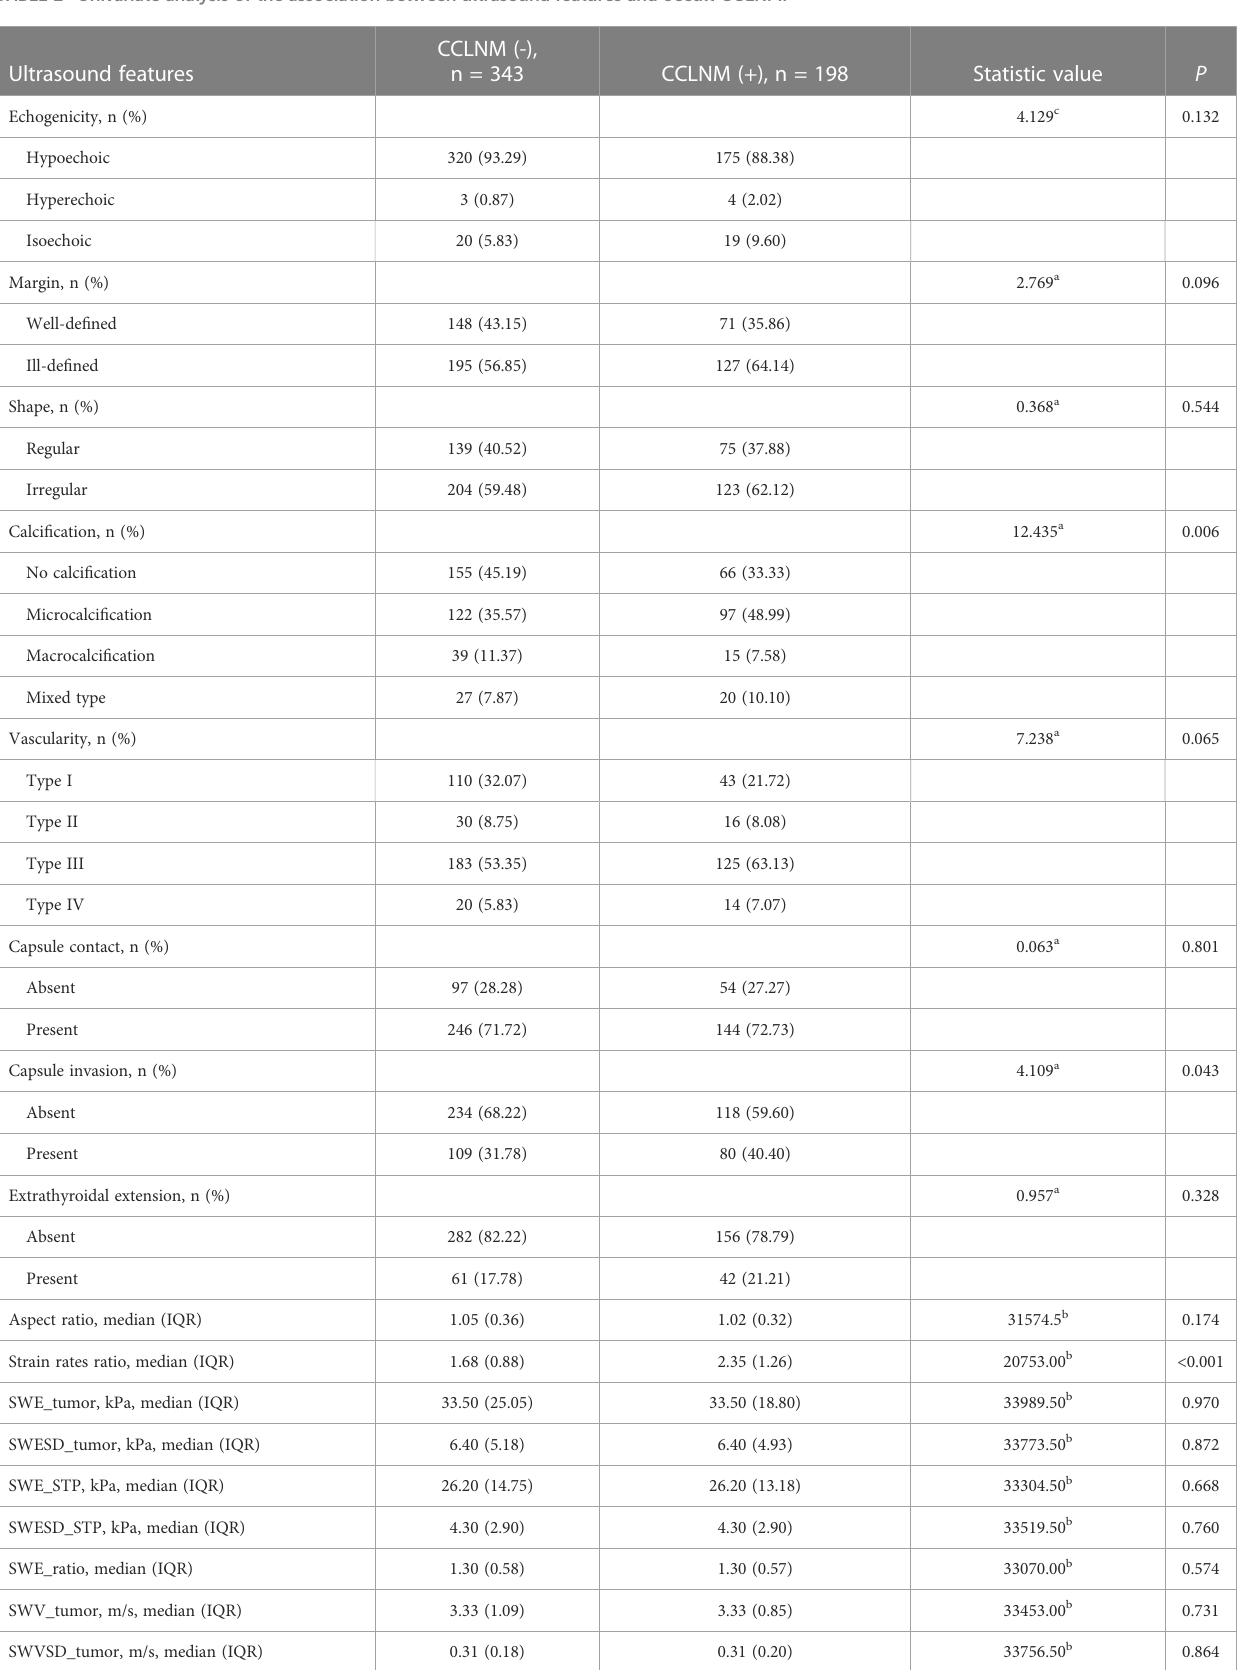
TABLE 2 Univariate analysis of the association between ultrasound features and occult